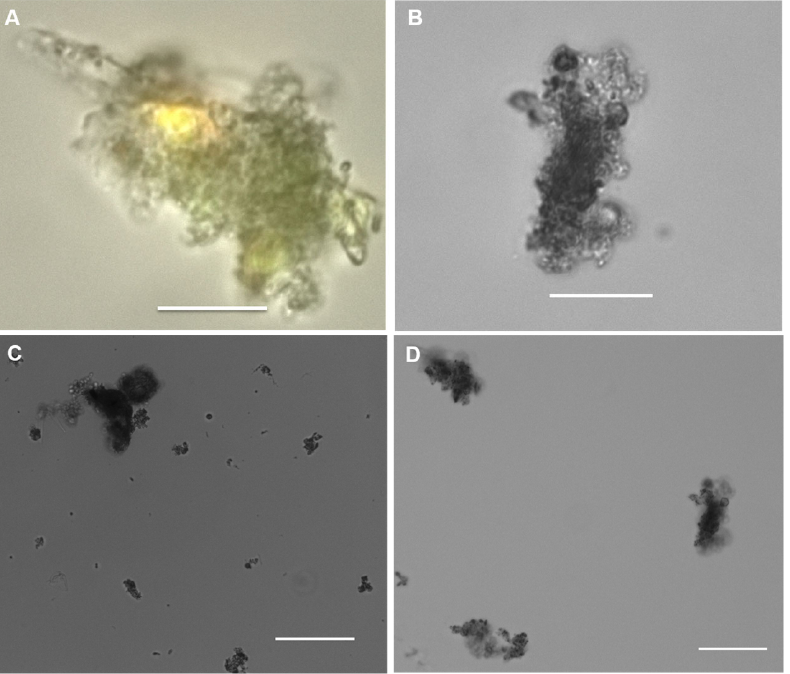
Figure 1. Marine gel particles recovered from PC filters after re-suspension in 0.2 µ m filter sterilised seawater. Scale bar = 20 µ m, image captured at 63 × objective and visualised with phase contrast ( A ). Scale bar = 50 µ m ( B – D ), image captured at 40 × objective for ( B ) and 20 × for ( C , D ) and visualised using bright-field microscopy.